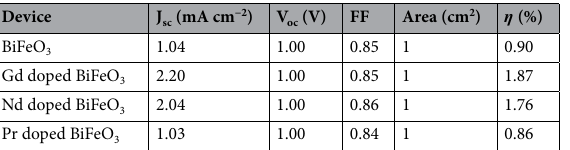
Table 2. Photovoltaic parameters of the DSSC fabricated by using an extracted Kiwi ( Actinidia deliciosa ) dye solution.